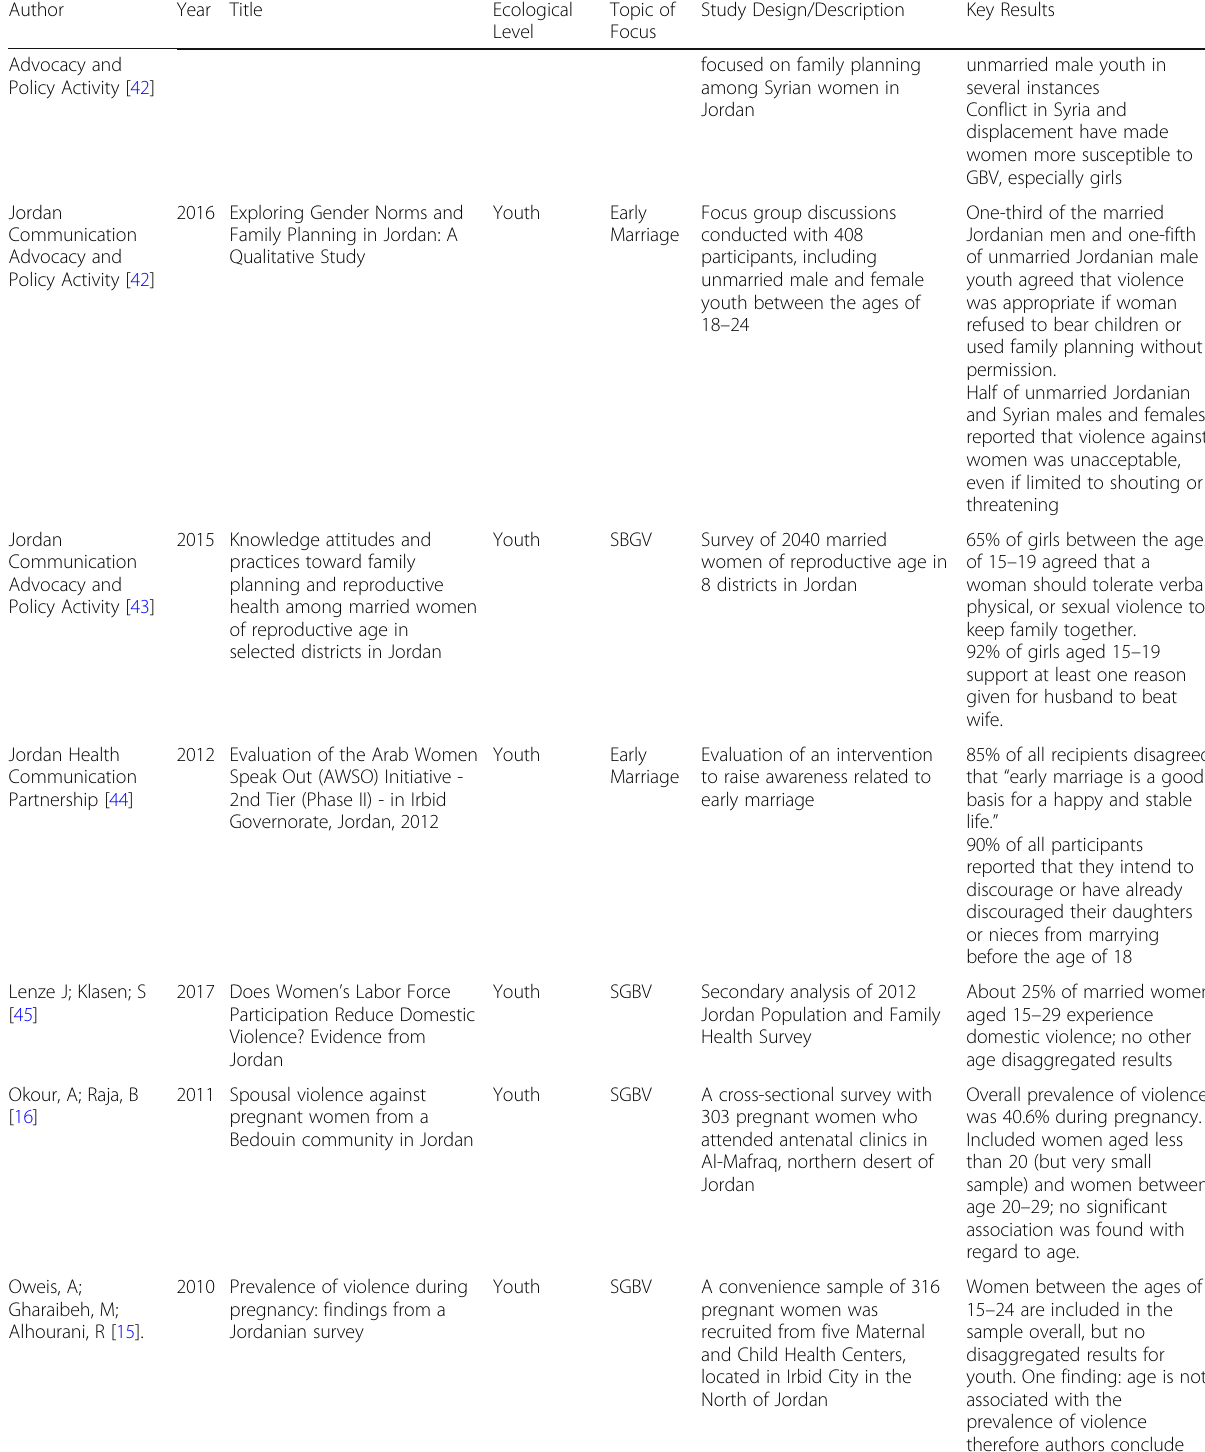
Table 1 Summary of the 27 documents included in the analysis according to ecological level and topic of focus pertinent to sexual- and gender-based violence and early marriage among youth in Jordan